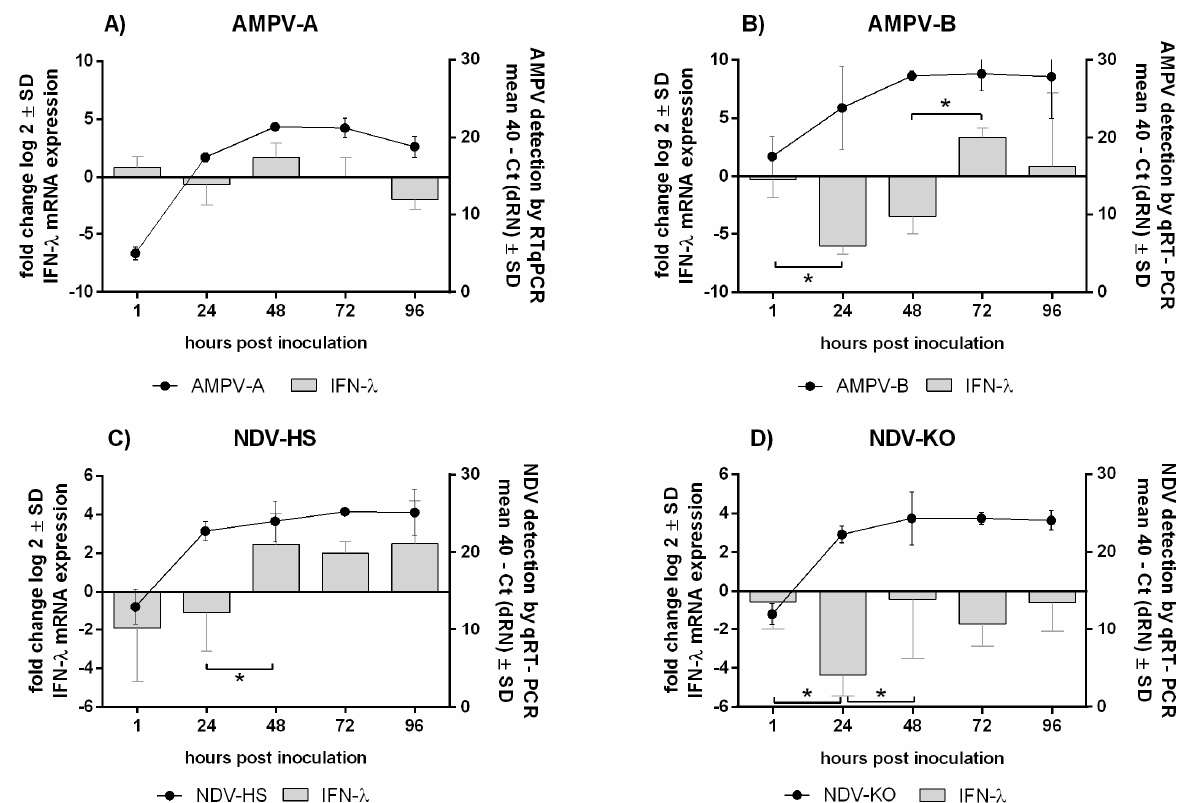
Figure 6. Quantification of IFN- λ mRNA expression in correlation with AMPV and NDV replication in TOCs. ( A ) AMPV-A, ( B ) AMPV-B, ( C ) NDV-HS, and ( D ) NDV-KO. Five rings/group/time points were investigated. Error bars indicate standard deviations. * indicate significant differences between